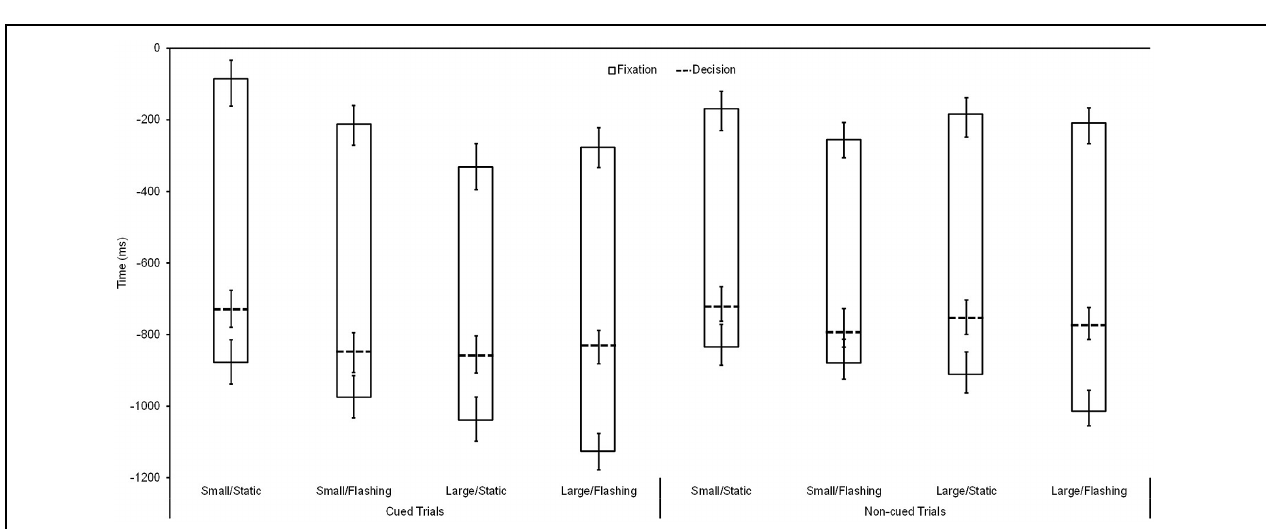
FIGURE 3 | Fixation onset, fixation offset, and response time ( M and SE , in ms) relative to the moment of subsequent ball reception ( = 0) as a function of cued vs. non-cued trials for all four marker types (small/static, small/flashing, large/static, and